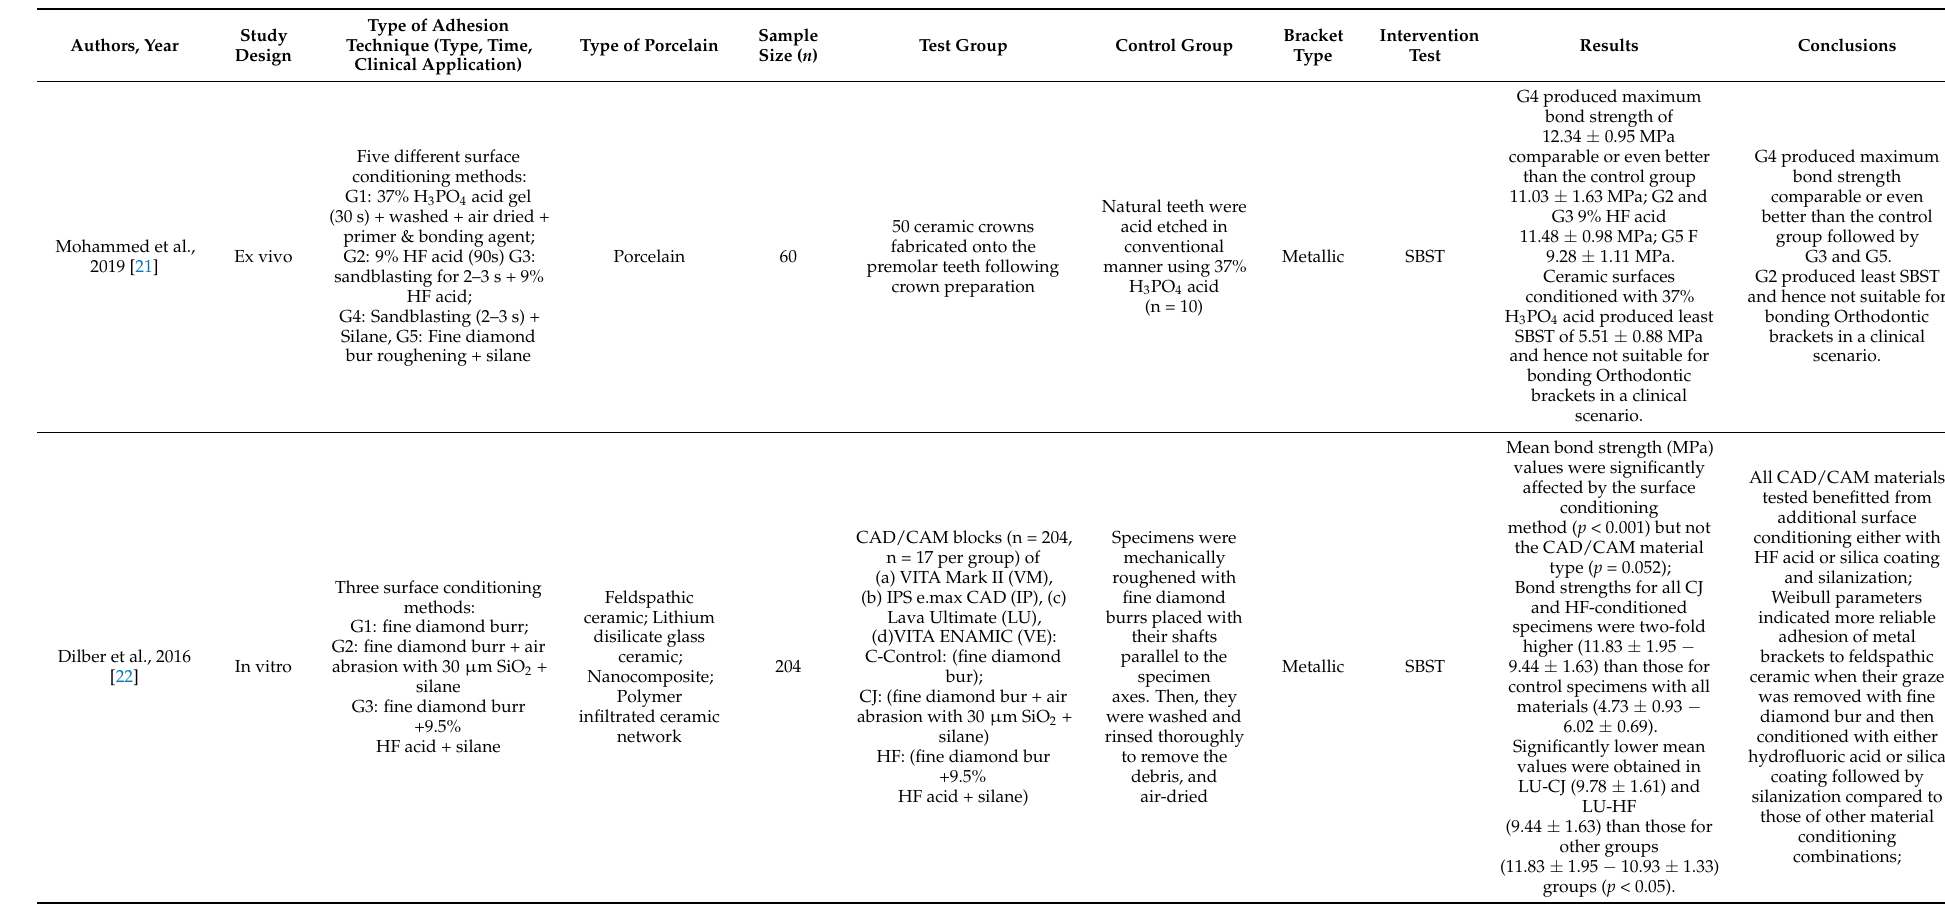
Table 2. Summary of parameters and results from in vitro and ex vivo included